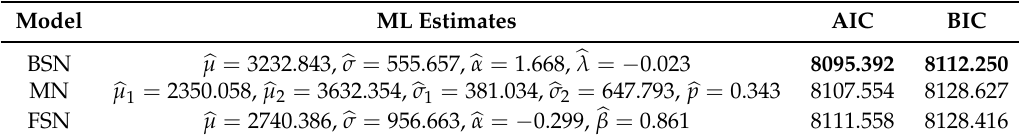
Table 9. ML estimates and Akaike’s information criterion (AIC) values for the three models.